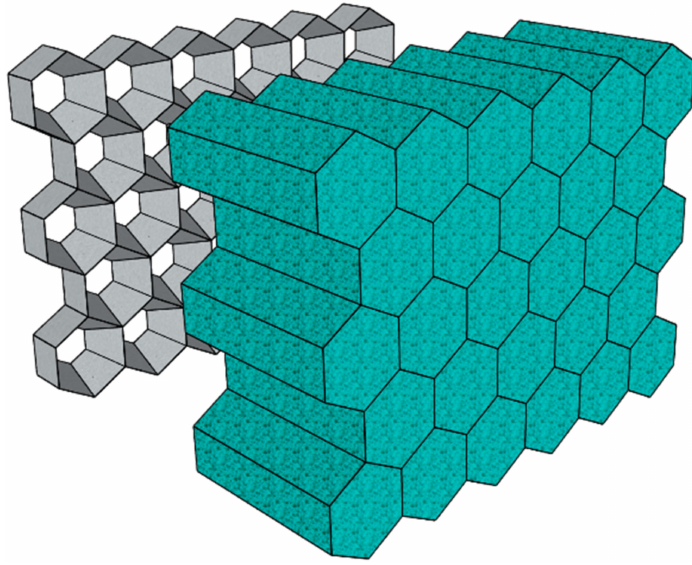
Figure 7. Collided foam strands exiting a multi-orifice